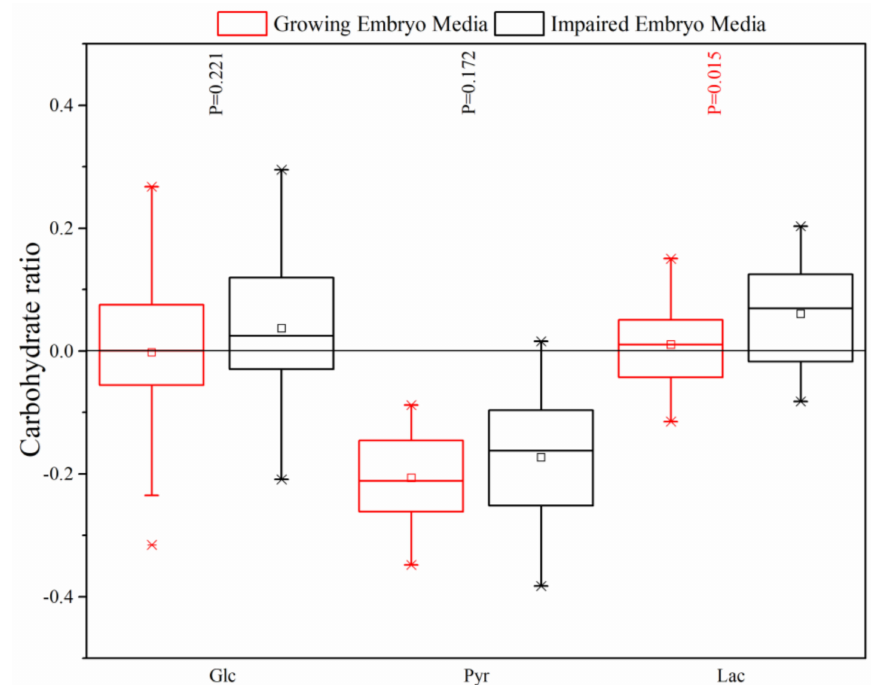
Figure 3. Comparison of the depletion / appearance of Glc, Pyr and Lac by the growing and impaired human embryos on day 5. The inset shows that Lac was significantly di ff erent between the growing and impaired embryos. Significant values have been marked in red above the graph ( p value <